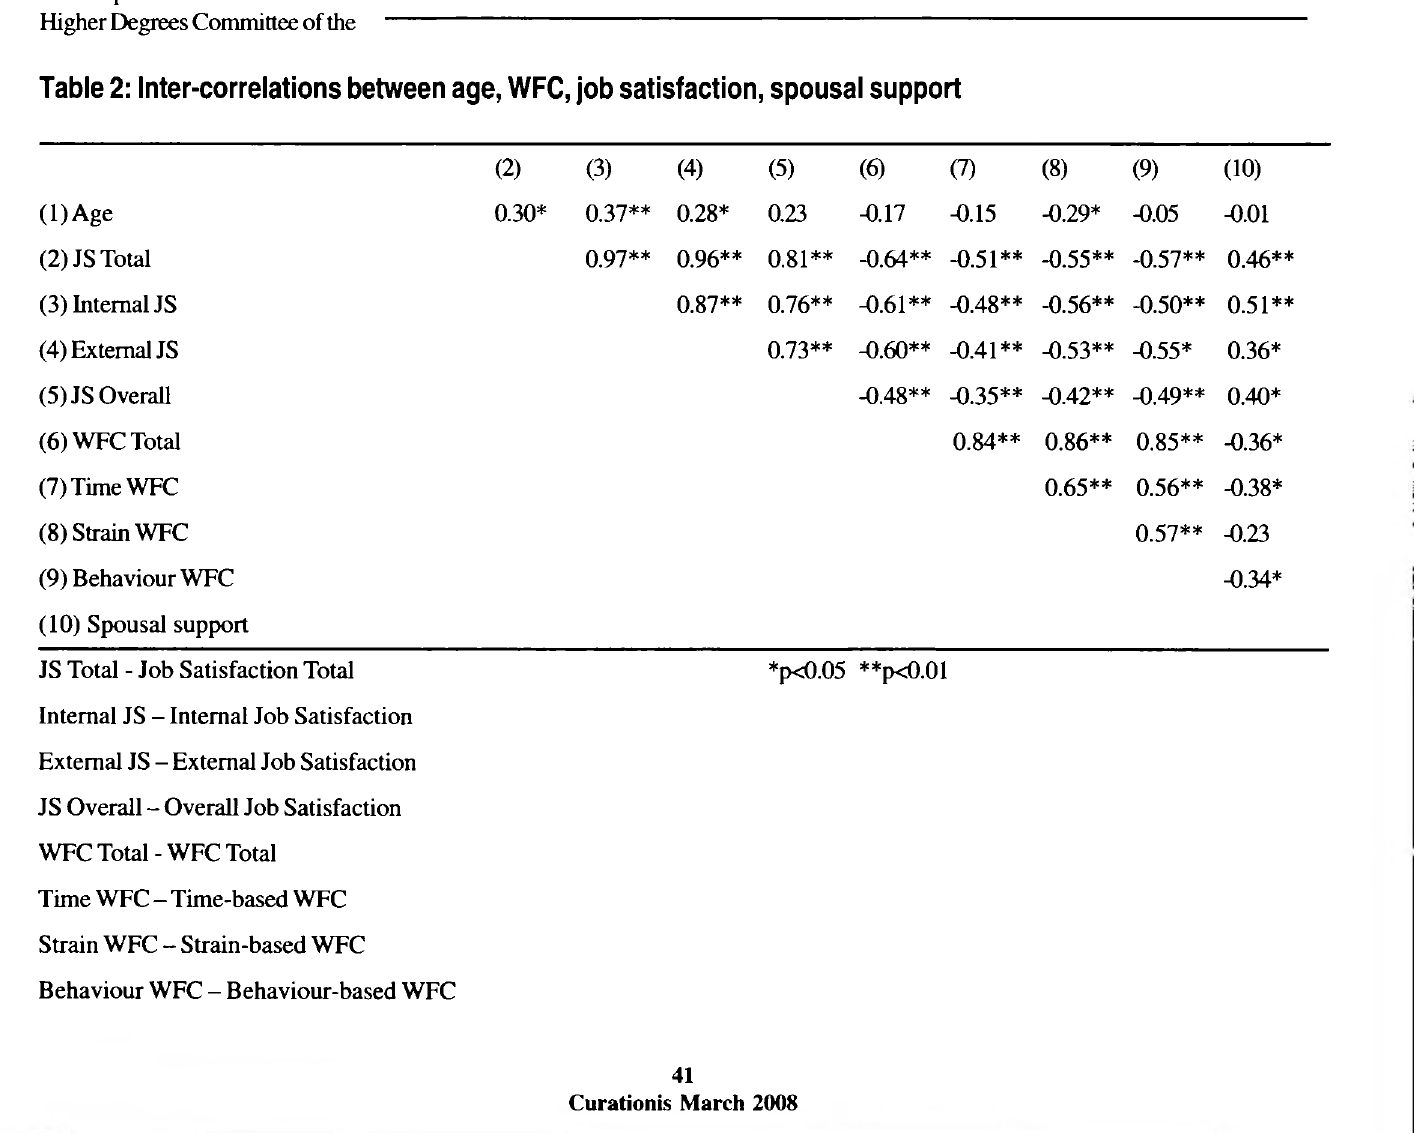
Table 2: Inter-correlations between age, WFC, job satisfaction, spousal